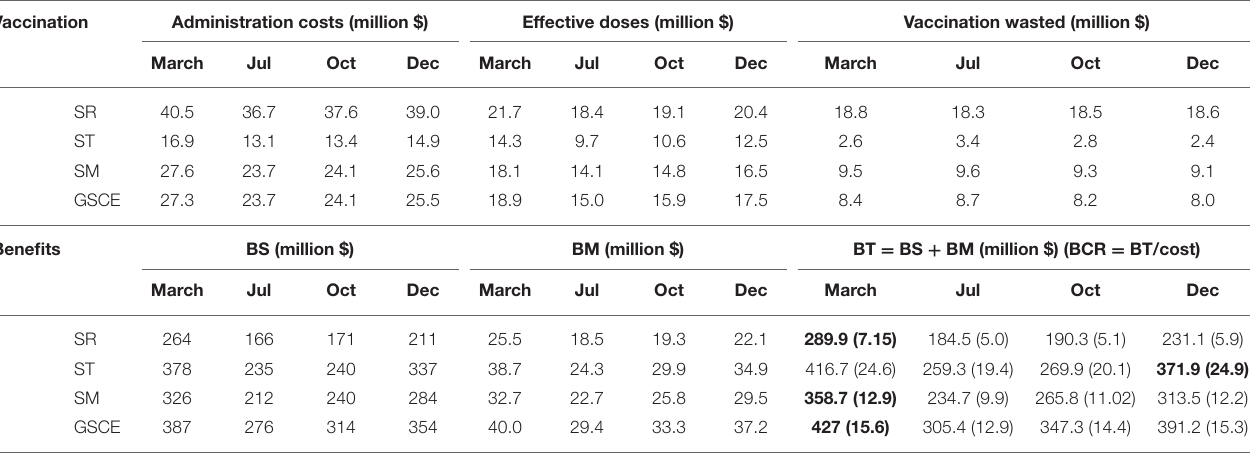
TABLE 5 | Cumulative costs and benefits from the different vaccination scenario.